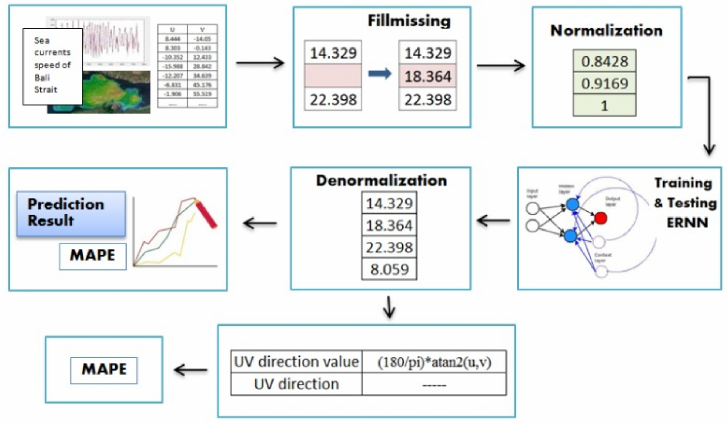
Fig. 3 Theoretical Framework of